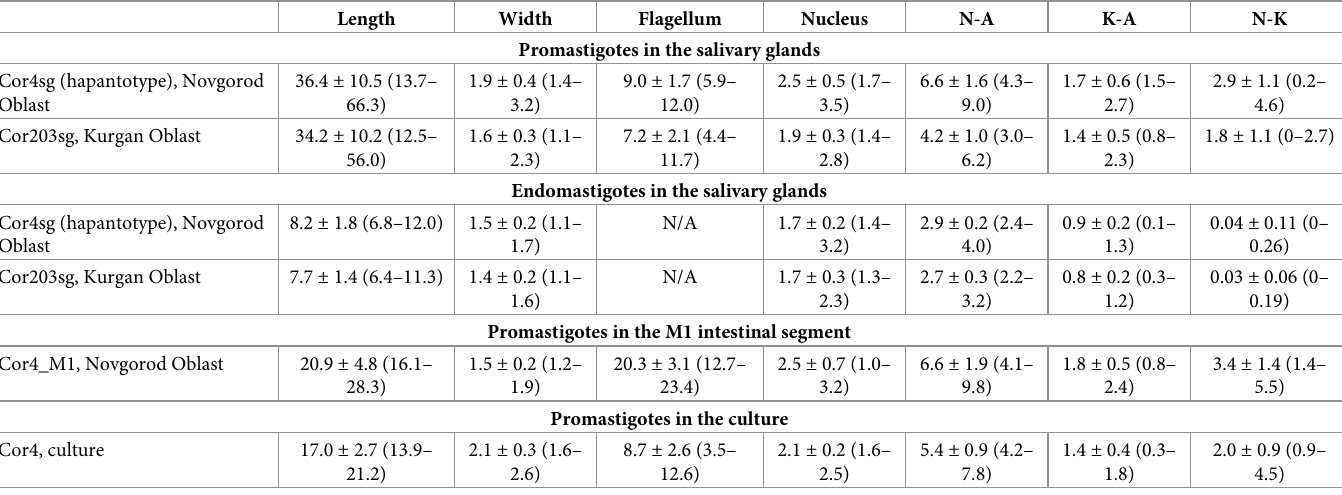
Table 1. Morphometry of different cell types of P . lipae from culture, different populations and different organs of the hosts (N =